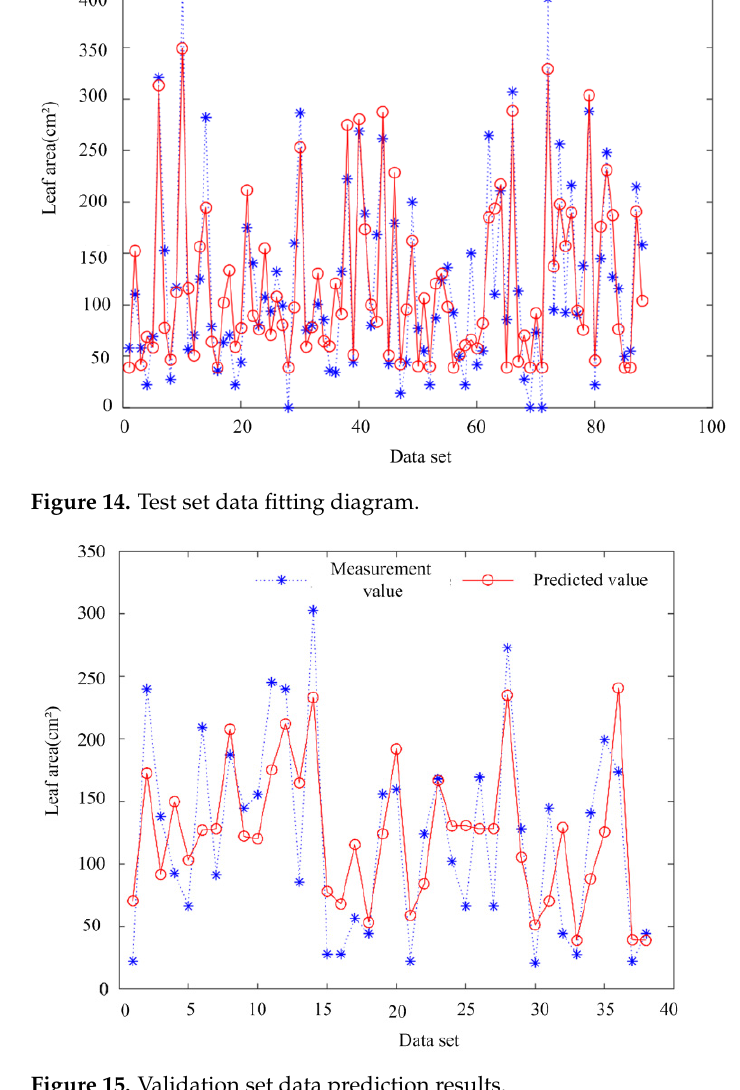
Figure 15. Validation set data prediction results.